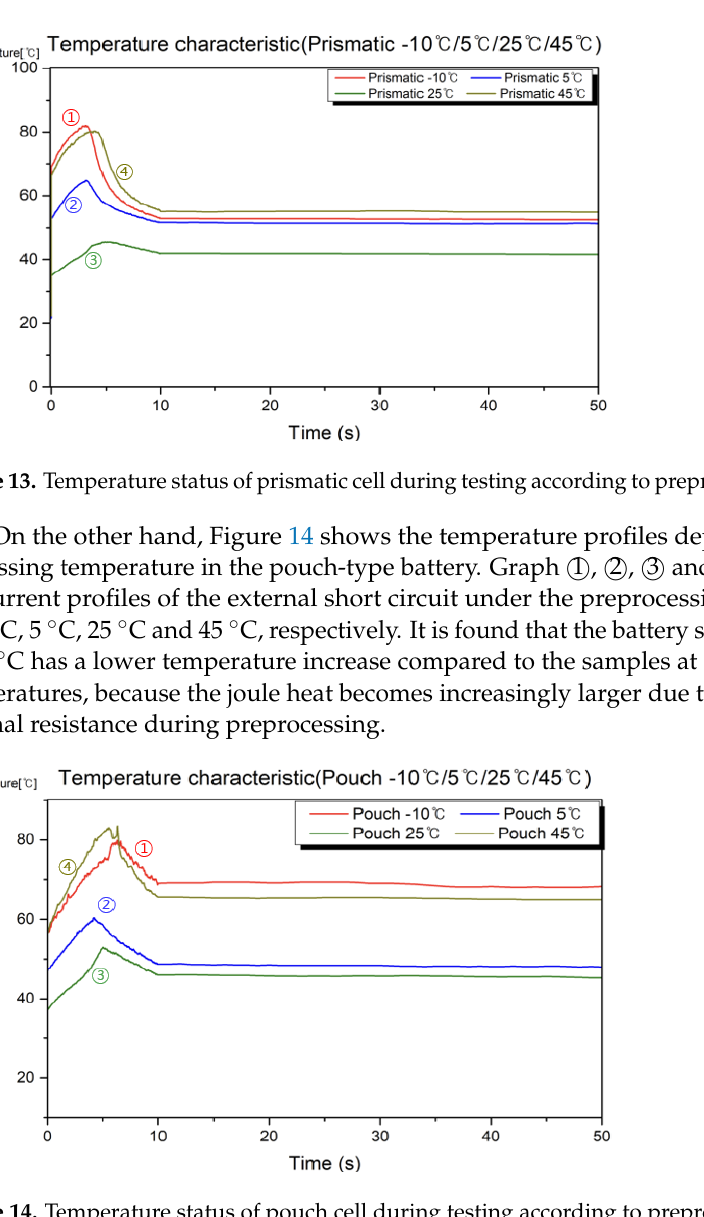
Figure 12. Current status of pouch cell during testing according to preprocessing temperature.